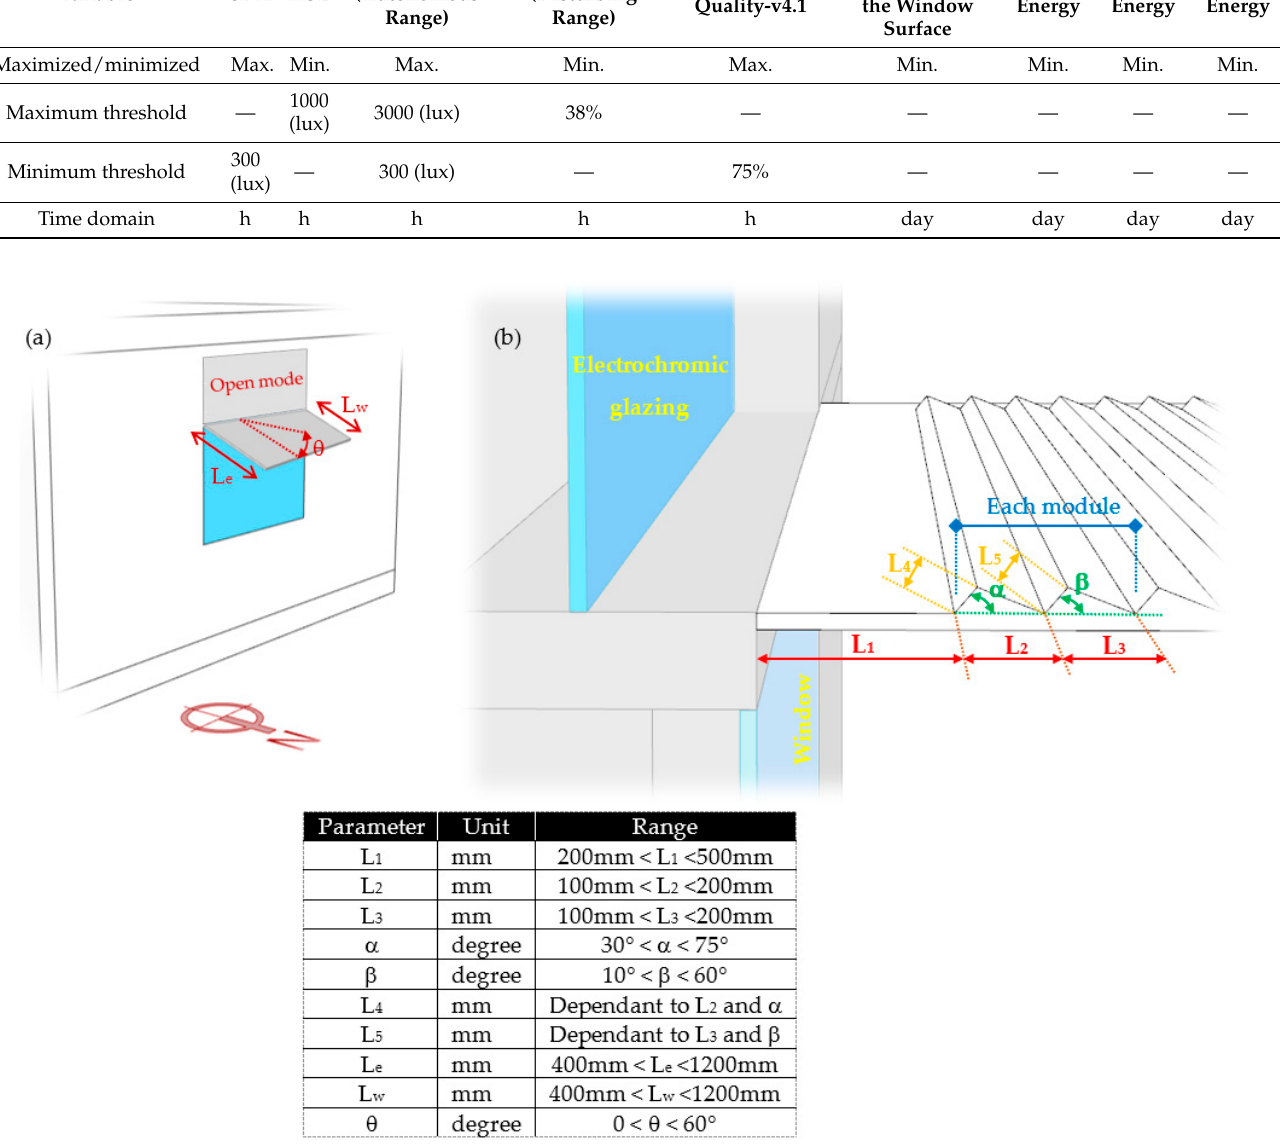
Figure 5. ( a ) SLS general shape parameters ( b ) SLS element surface parameters to be optimized ( α , β , L 1 , L 2 , L 3 , L 4 , and L 5 ); and ( c ) parameters ranges. Spatial Daylight Autonomy